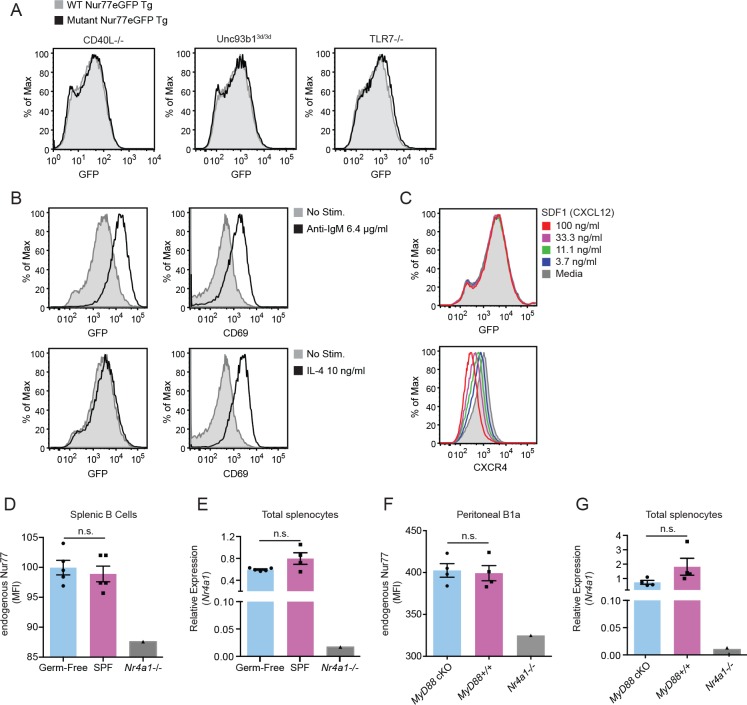
Regulation of endogenous Nur77 and Nur77-eGFP reporter expression.(A) Nur77-eGFP expression in mature Fo (B220+CD93-CD23+) B cells from mice with mutations in various signaling pathways (CD40L−/−, Unc93b13d/3d,TLR7−/−). This Unc93b1 mutation abolishes signaling through TLR3, TLR7, and TLR9. (B) Nur77-eGFP and CD69 induction in B220+ splenocytes from Nur77-eGFP reporter mice stimulated with either anti-IgM or IL-4 in vitro for 24 hr. (C) Splenic B cells were stimulated with CXCR4 ligand (SDF-1) in vitro for 18 hr and Nur77-eGFP expression and CXCR4 downregulation were assessed. (D–E) Splenocytes from N = 5 Germ-free and SPF mice were taken directly ex vivo and either permeabilized and stained to detect B220+ cells and endogenous Nur77 by intracellular staining (D), or total Nr4a1 transcript by qPCR (E). (F) PerC (peritoneal cavity) cells from n = 4 MB1-Cre+ MyD88fl/fl and controls were permeabilized and stained immediately ex vivo to detect B1a cells and endogenous Nur77 by intracellular staining. (G) Splenocytes from mice analyzed in (F) were harvested directly ex vivo to detect total Nr4a1 transcript by qPCR. In D-G, Nr4a1-/- splenocytes serve as a control for both Ab and primer specificity. Data in (A) and (C) are representative of n = 2 independent experiments. Data in (B) are representative of n = 3 independent experiments.